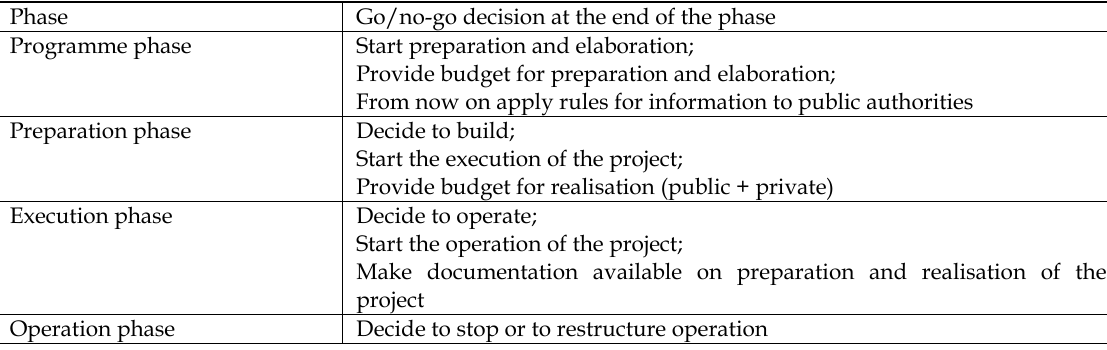
Table 2. Stages of a project and go/no-go